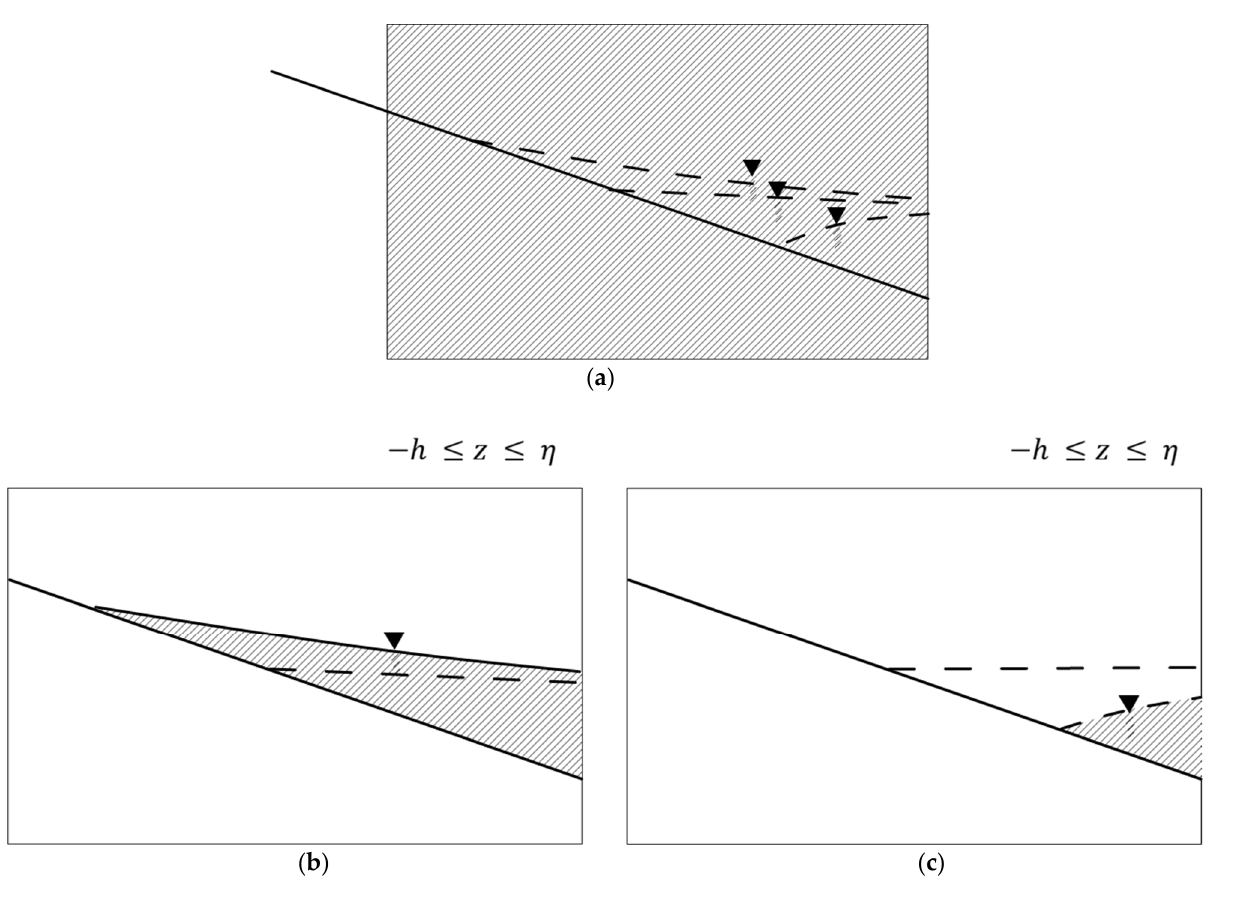
Figure 3. Physically valid domain vs. mathematical domain: ( a ) mathematical domain: whole domain; ( b ) valid between crest and bed; ( c ) valid between trough and bed.